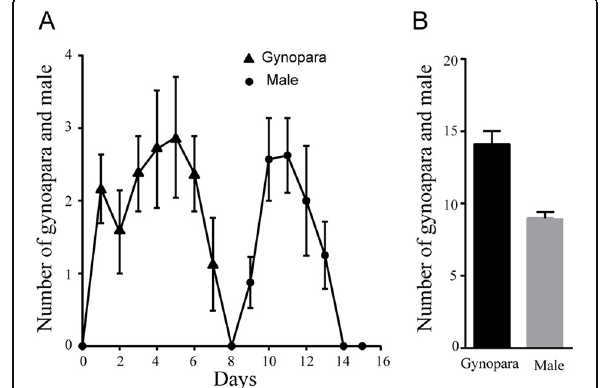
Fig. 2 Reproductive schedules of cotton aphid under short-day condition. a Daily number of GPe and males produced by parthenogenetic females, which were reared under short-day condition from newly-born stage at 18 °C and a photoperiod of 8 L:16D. b Number of GPe and males produced by each parthenogenetic female at 18 °C and a photoperiod of 8 L:16D ( n =